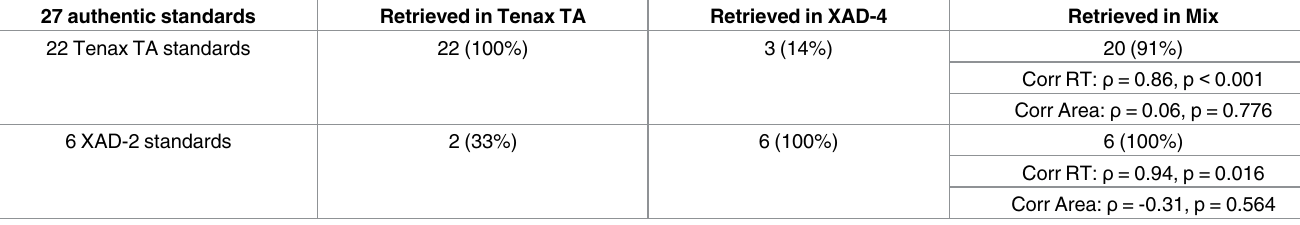
Table 3. Number of confirmed compounds retrieved dependent on the adsorbent